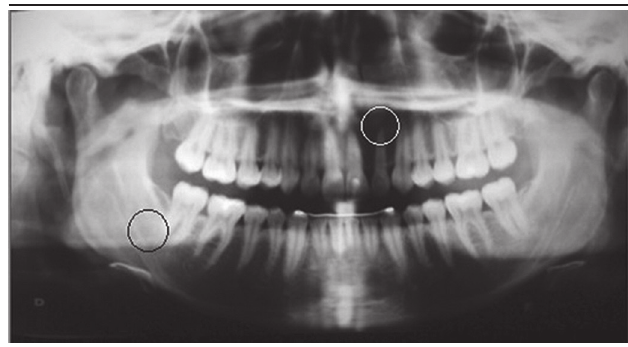
figurE 2 − Panoramic radiograph prior to treatment: ROI test (white circle) and initial control (black circle) in the area before intralesional corticosteroid application ROI: region of interest.